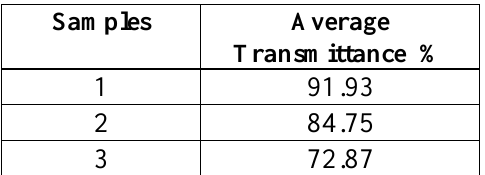
Transmittance for three glass samples (1, 2, and 3) Samples